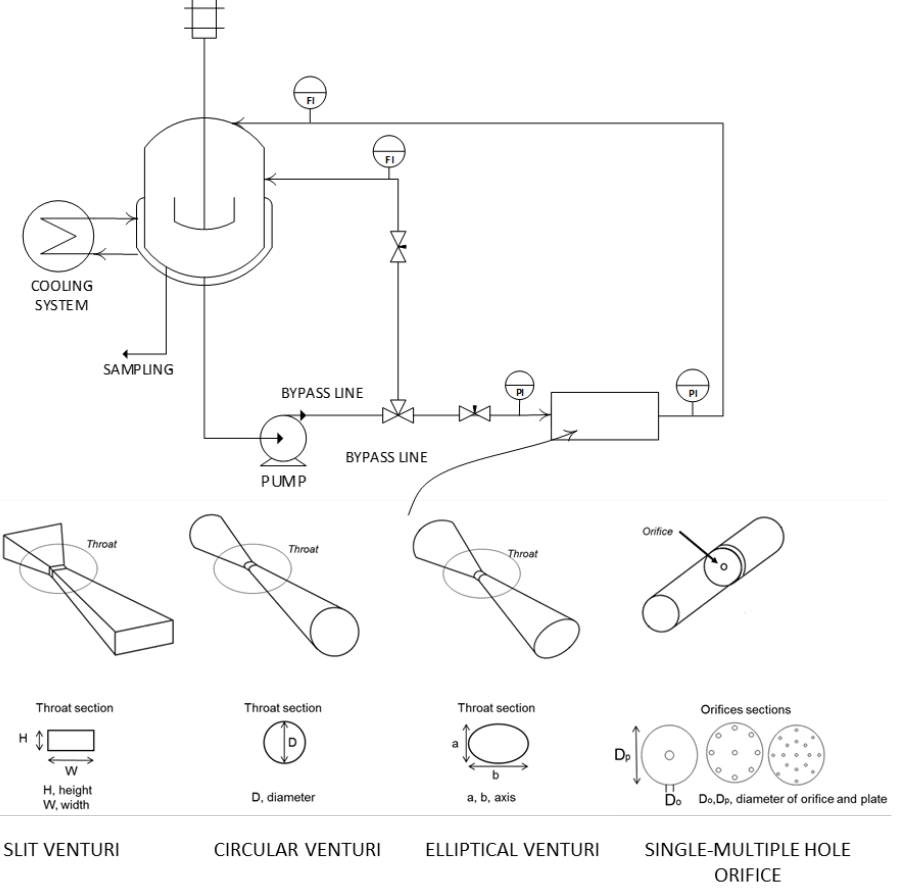
Figure Figure 1. Schematic representation of the “typical” experimental setup adopted in the cited hydrodynamic cavitation (HC) studies (with the most used constriction configurations).